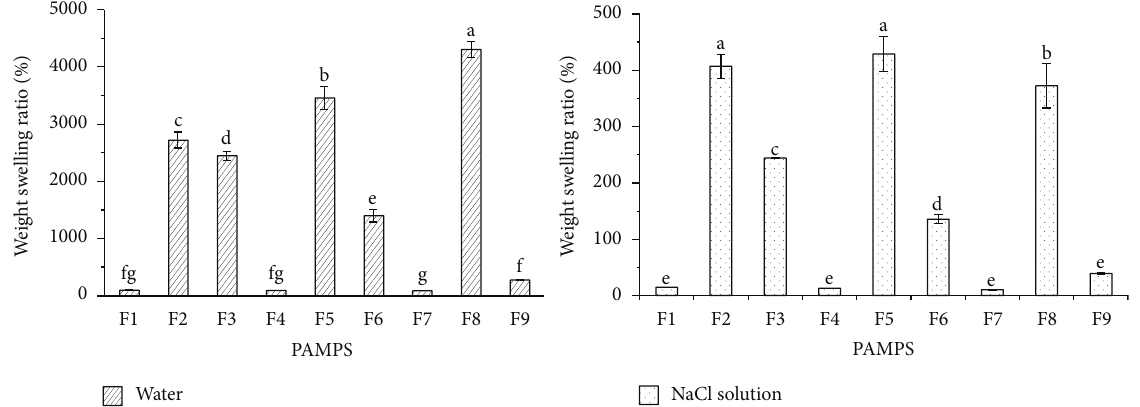
Figure 2: Weight swelling ratios of PAMPS hydrogels in water and salt solution for 24 h at 25 ∘ C. Lowercased letters mean significant difference (a = 0.05 , LSD) among different PAMPS hydrogels. The formulas of different PAMPS hydrogels are shown in Table 1. Error bars represent ± S.E.